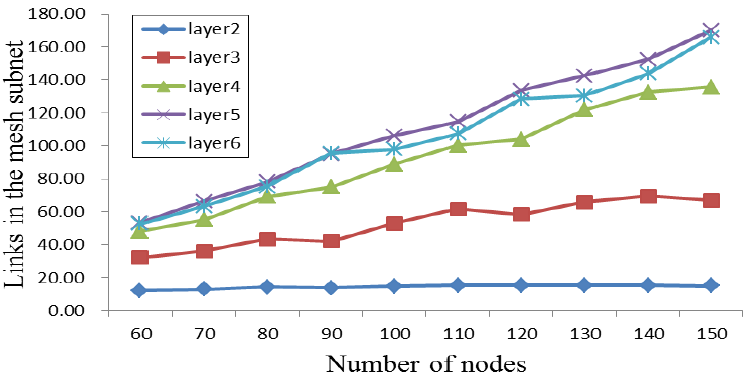
Figure 4. The total number of links in the mesh-shaped topology.